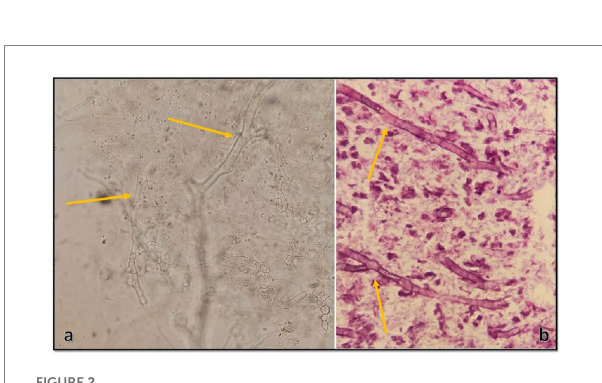
FIGURE 2 (A) Direct KOH microscopy of tissue samples. Broad aseptate hyphae with wide-angle branches, and narrow septate hyaline hyphae with acute branching, are seen (×400). (B) Histopathological examination of tissue sections revealing a vascular structure involved, and containing both broad and thin fungal hyphae